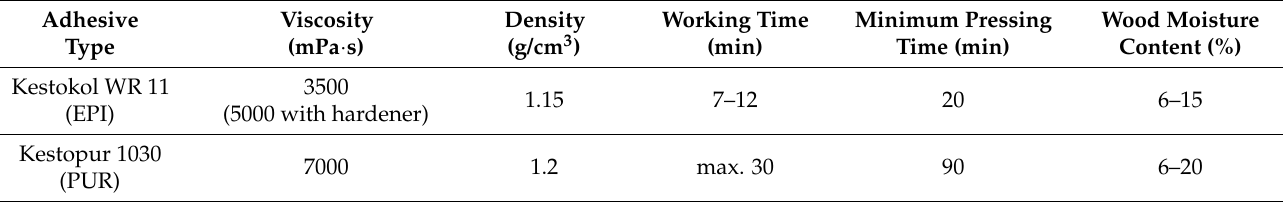
Table 1. Properties of PUR and EPI